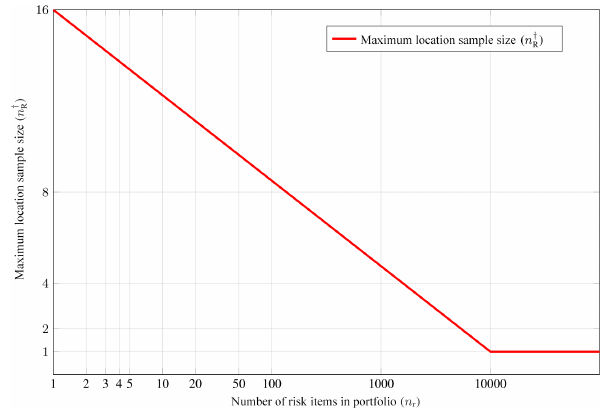
Figure 8. Criterion I: number of samples per zone depending on co- efficient of variation. The discrete realization of the criterion (lim- ited to powers of 2) is shown in blue, while the red line represents the theoretical linear behavior.